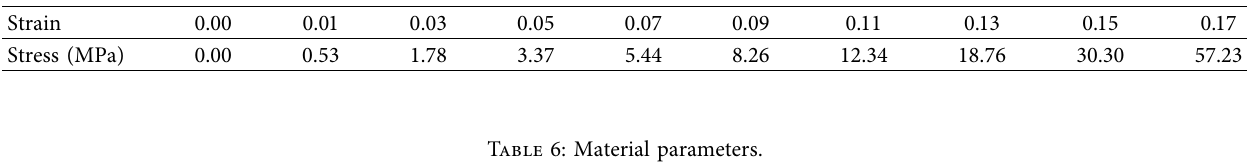
Table 6: Material parameters.